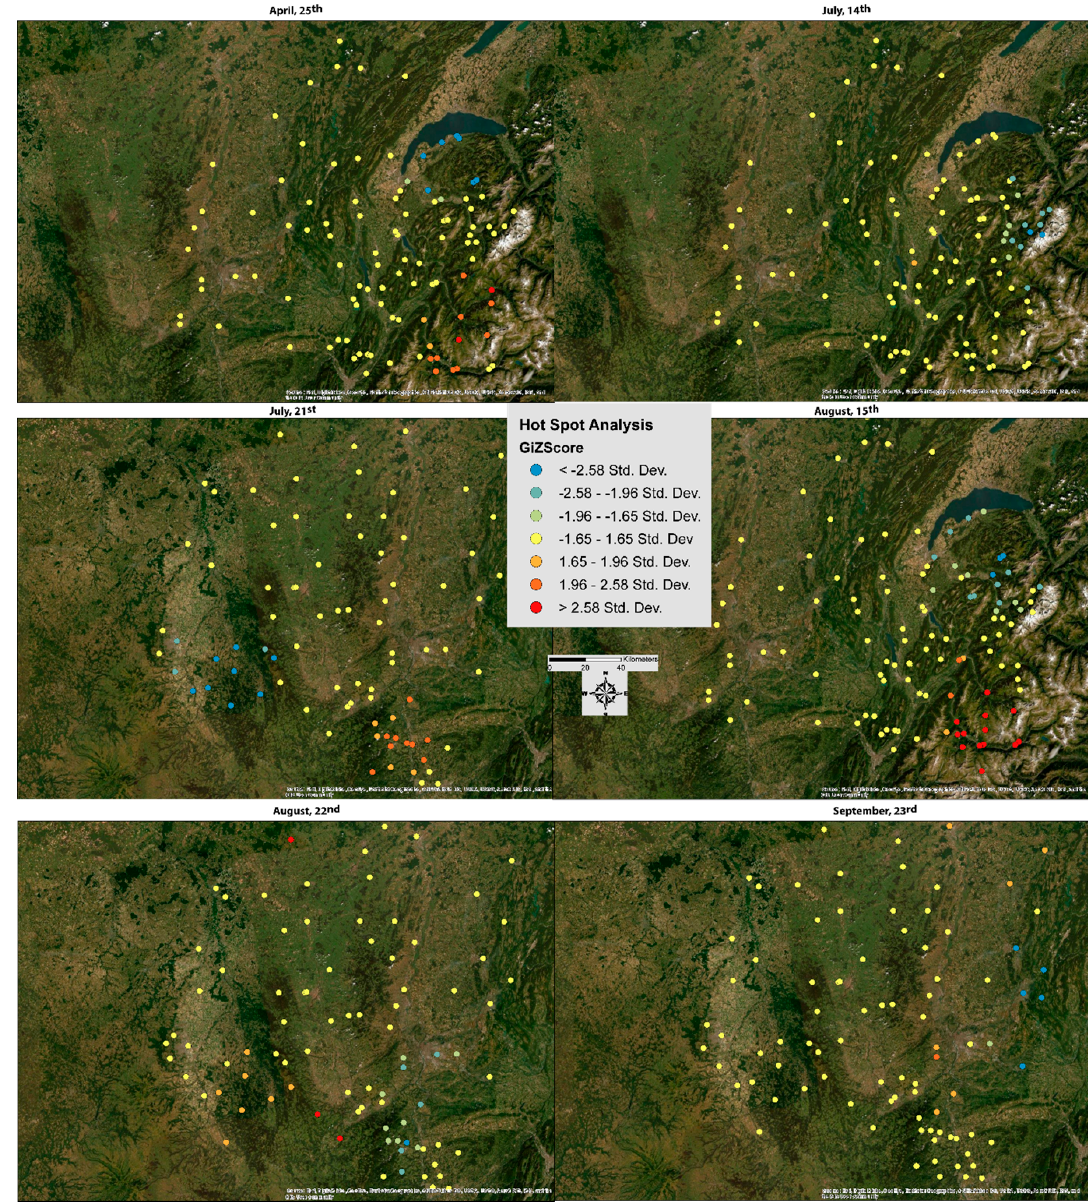
Figure 6. Getis Ord GI* of the relative differences between in situ and modelled air temperatures for each day studied.